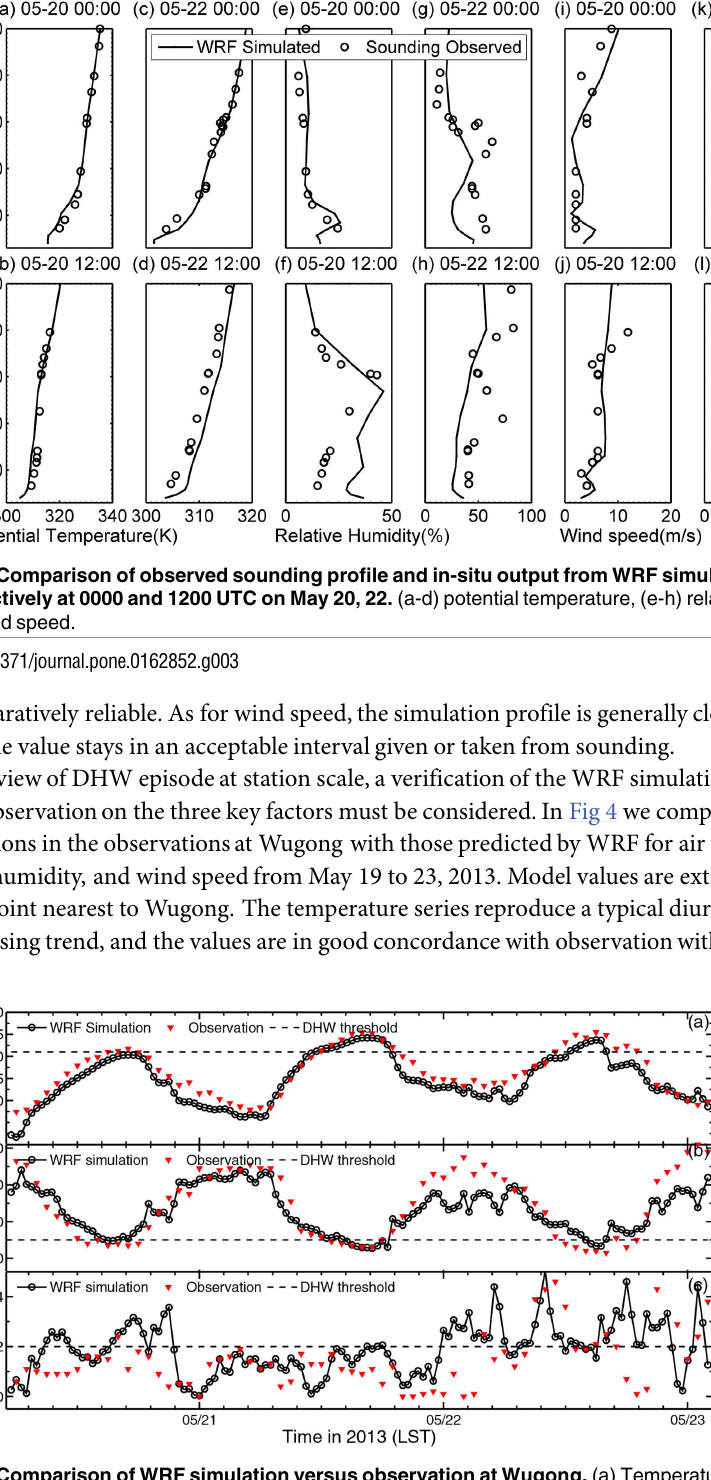
Fig 4. Comparison of WRF simulation versus observation at Wugong. (a) Temperature at 2m height, (b) relative humidity at 2m height and (c) near surface horizontal wind speed. In each panel figures, a horizontal dash line indicatesthe DHW threshold for each